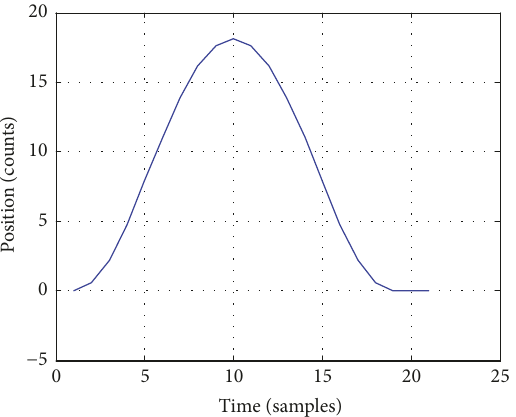
Figure 5: The position waveform of PMSM in continuous case.